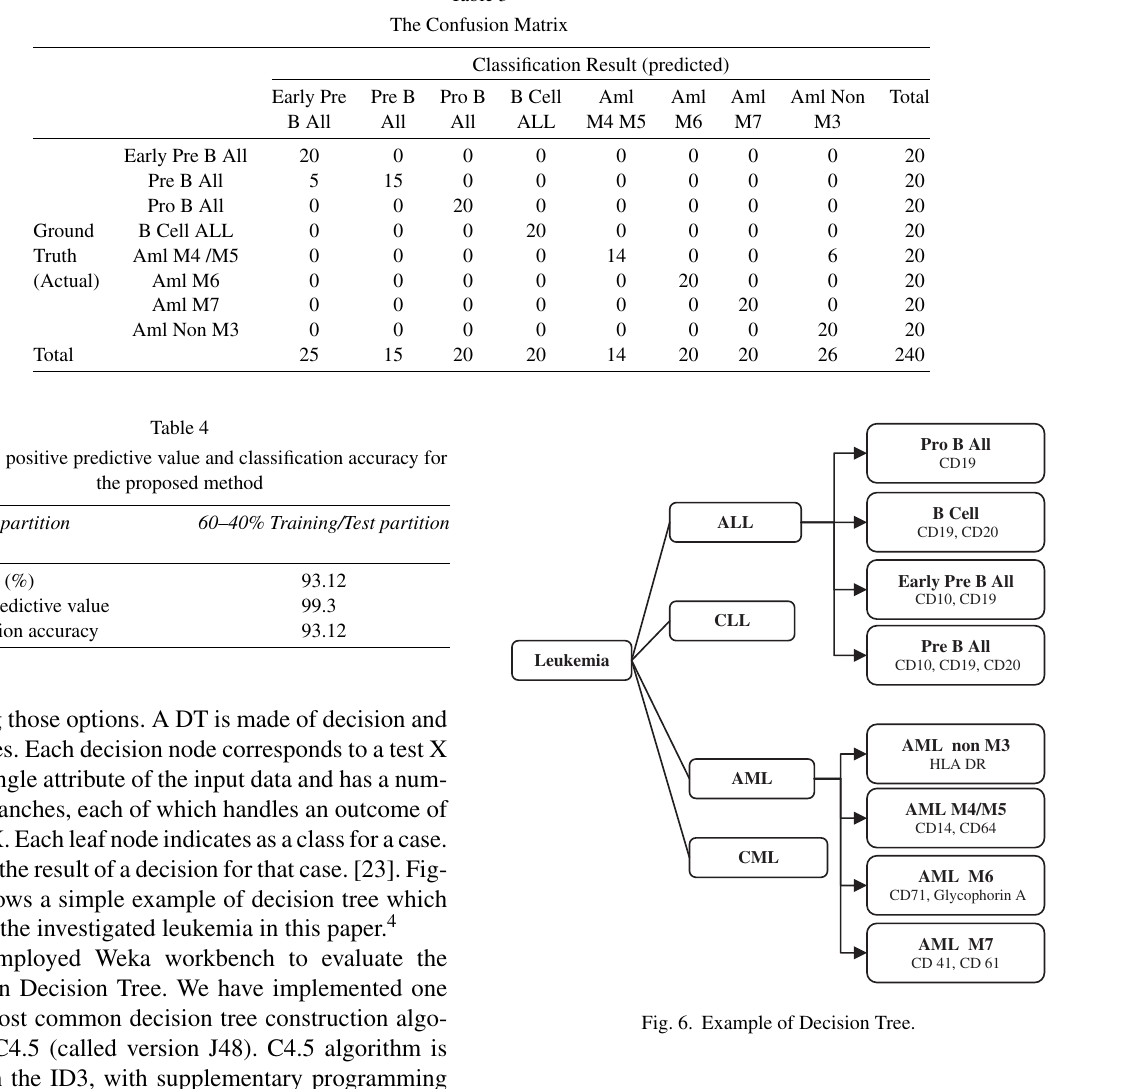
Fig. 6. Example of Decision